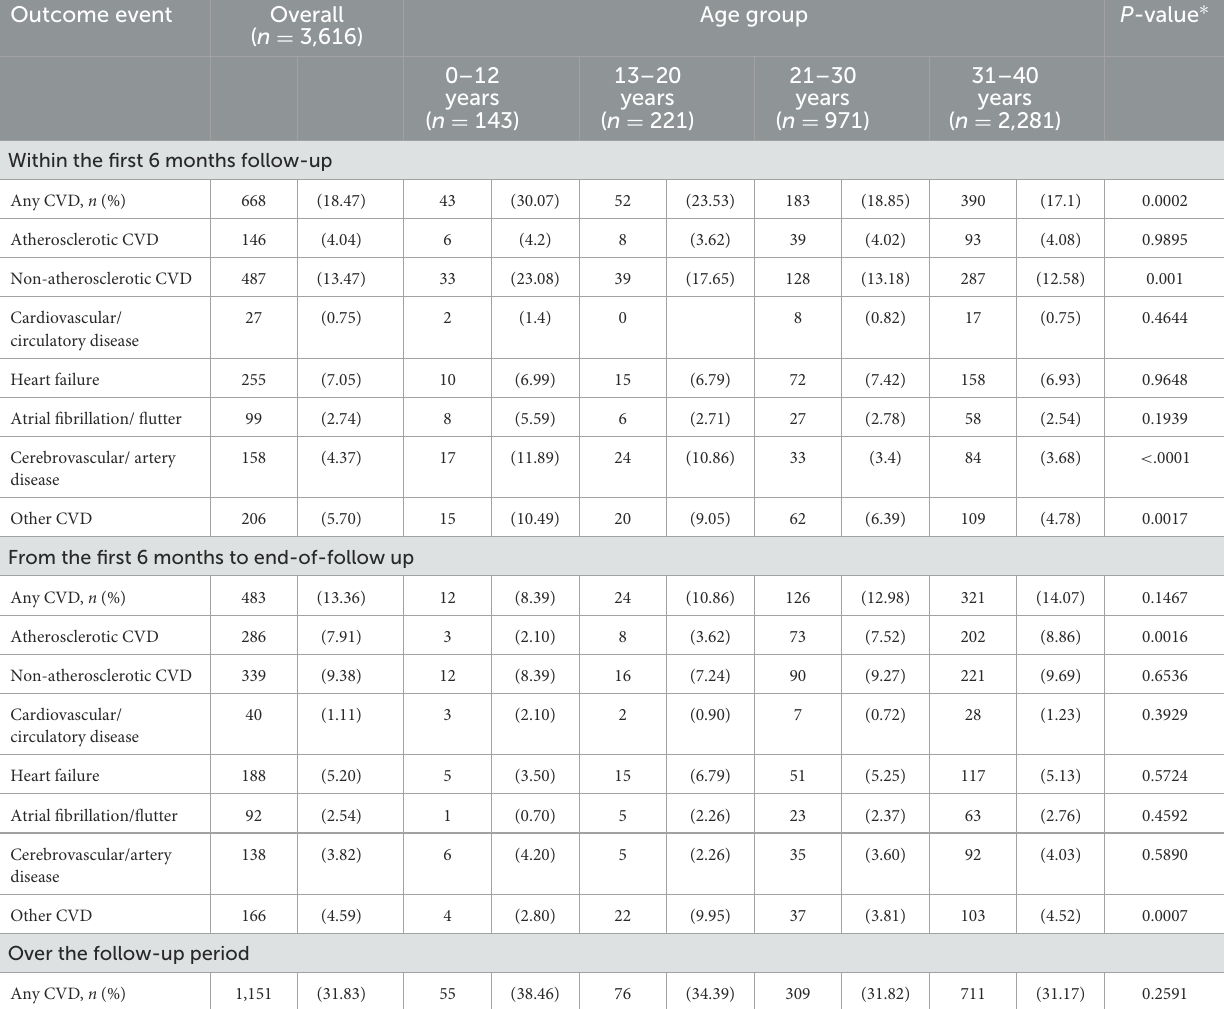
TABLE 2 Incidence rate of cardiovascular disease and mortality rate by age